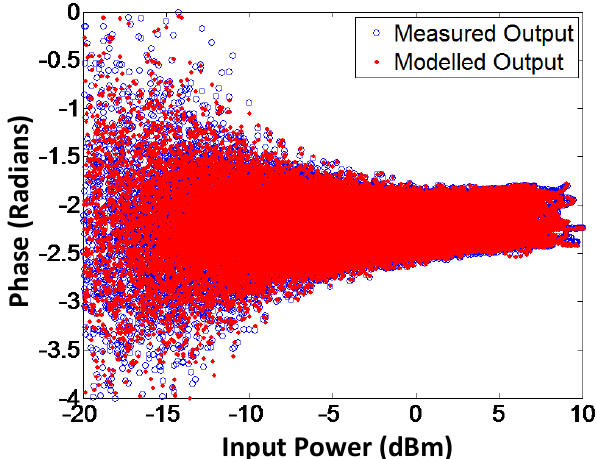
Figure 12. AM-PM characteristics of modeled and measured output signals for the analog combining architecture. The figure illustrates that the proposed augmented memory polynomial-based method is capable of modeling the phase response of the transmitter for analog combining.